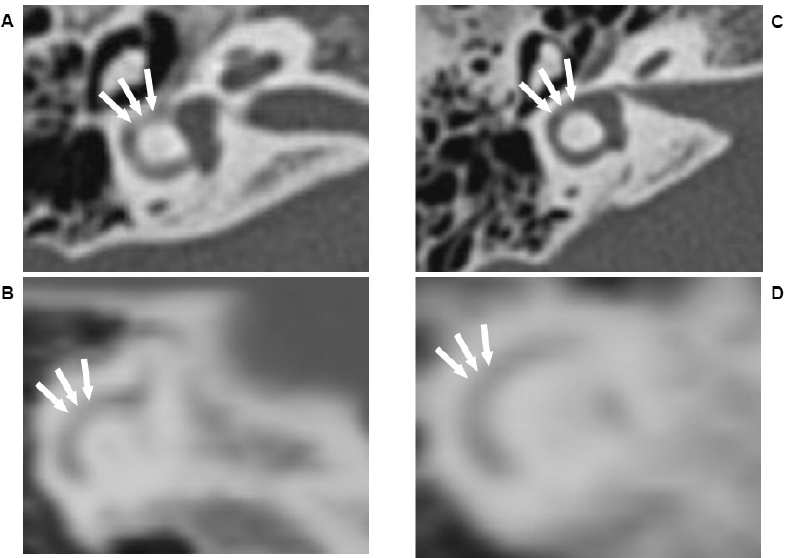
Figure 1. ( A , B ) demonstrated the horizontal semicircular canal ( A ) and posterior semicircular canal ( B ) of Ms. A, there were several snowy dots detected (white arrow), which represent the scattering effect: the X-ray had been scattered by the suspended otolith (also called otoconia, size of 10 μ m) so that it could not be detected by the X-ray film and represent in white color in the final HRCT image; ( C , D ) demonstrated the horizontal semicircular canal ( C ) and posterioir semicircular canal ( D ) of Mrs. B, there was no any scattering effect noticed (white arrow): this was resulted from that there was no suspended otolith in the endolymph so that the X-ray could smoothly pass through the endolymph without being scattered. Therefore, after absorbed by the X-ray film, the HRCT would show black color in the final image. The detailed information for HRCT settings were: Multiplanar reformation (MPR) Dose CT dose index volume 37.42mGy FOV 270 mm Slice thickness 0.6 mm Scan mode: CT sequential CT image acquisition Partial volume can be avoided by using acquisition section width and iso voxel 0.53 × 0.53 × 0.6 mm 3 . 270/520 =